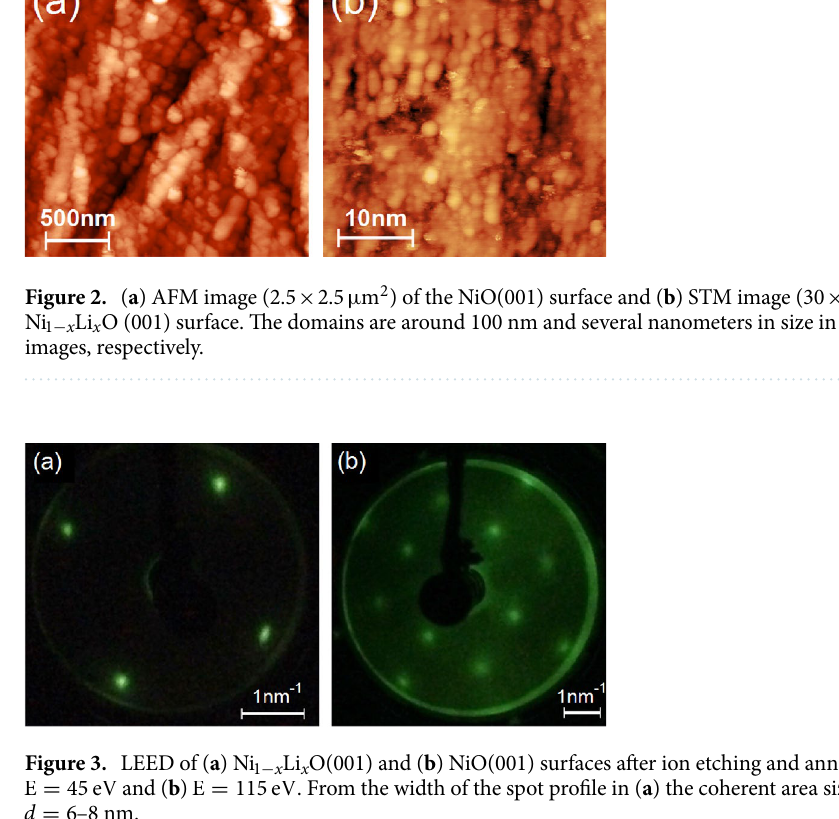
Figure 3. LEED of ( a ) Ni 1 − x Li x O(001) and ( b ) NiO(001) surfaces after ion etching and annealing. ( a ) E = 45eV and ( b ) E = 115 eV . From the width of the spot profile in ( a ) the coherent area size is estimated to be d = 6 –8